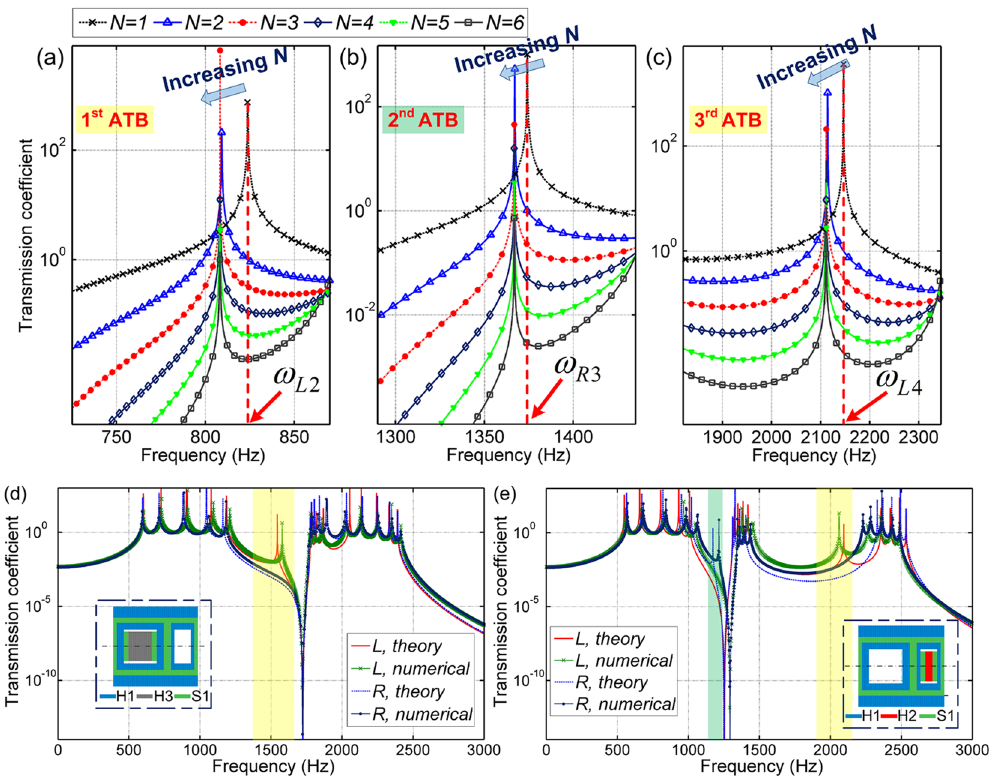
Figure 6. Effect of the unit cell number on the asymmetric peak frequencies in the ( a ) 1 st , ( b ) 2 nd and ( c ) 3 rd ATBs. Theoretical and numerical transmission coefficient-frequency profiles for a finite continuum rod built by the unit cell with ( d ) one ATB and ( e ) two